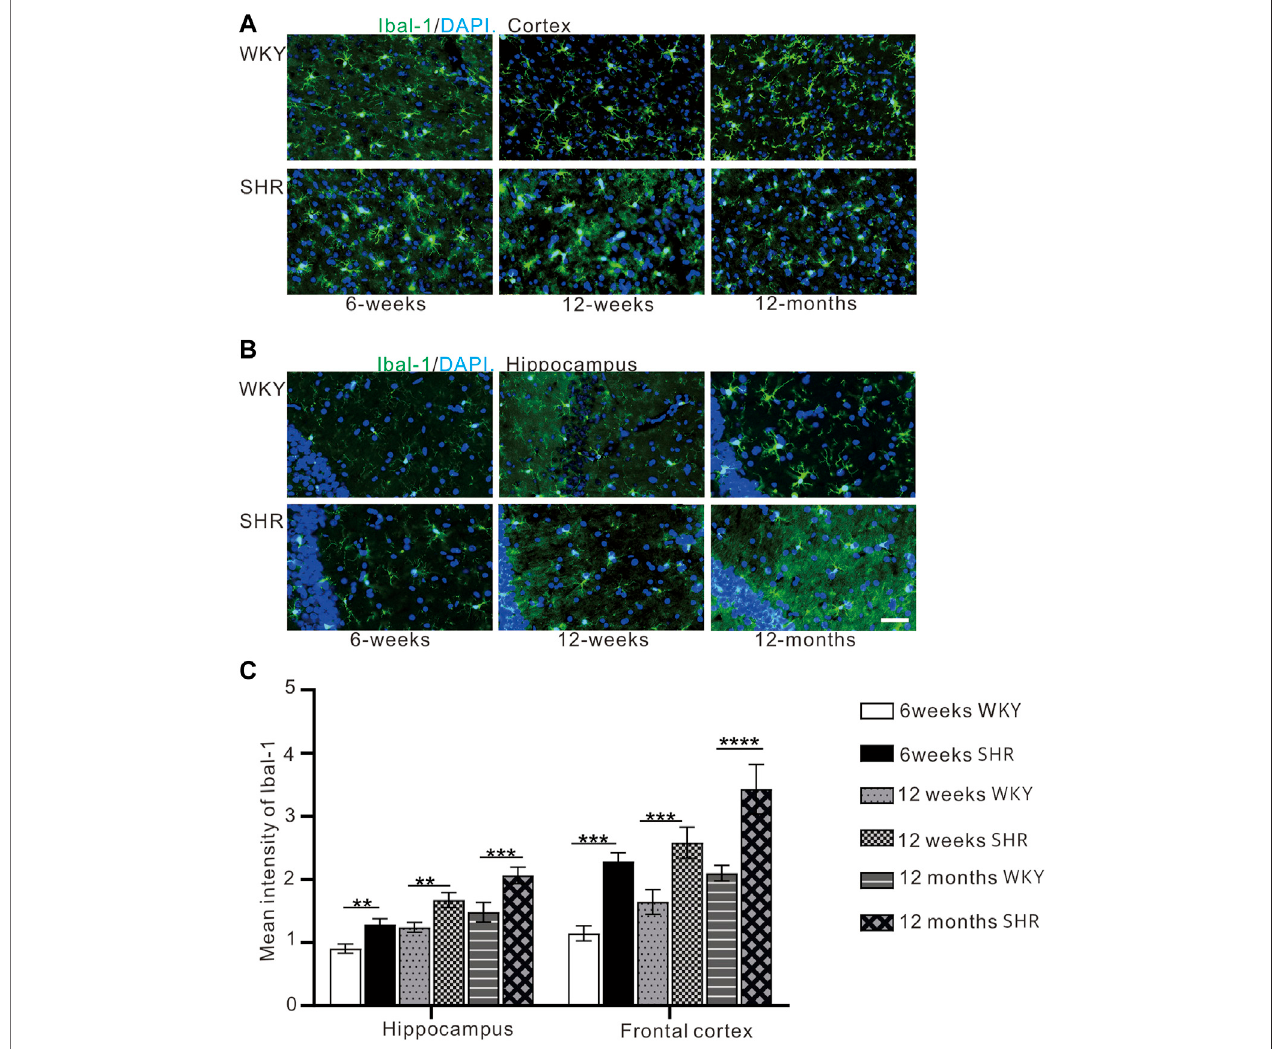
FIGURE 6| (A) The expression ofiba-1 in the prefrontal cortex of WKY and SHR. (B) the expression of iba-1in the hippocampal CA1 region ofWKY and SHR. (C) Iba-1 immuno fl uorescence showed thattheexpression ofiba-1protein inthecortexand hippocampusofSHRwasincreasedcomparedwith thatofWKY Group, bar